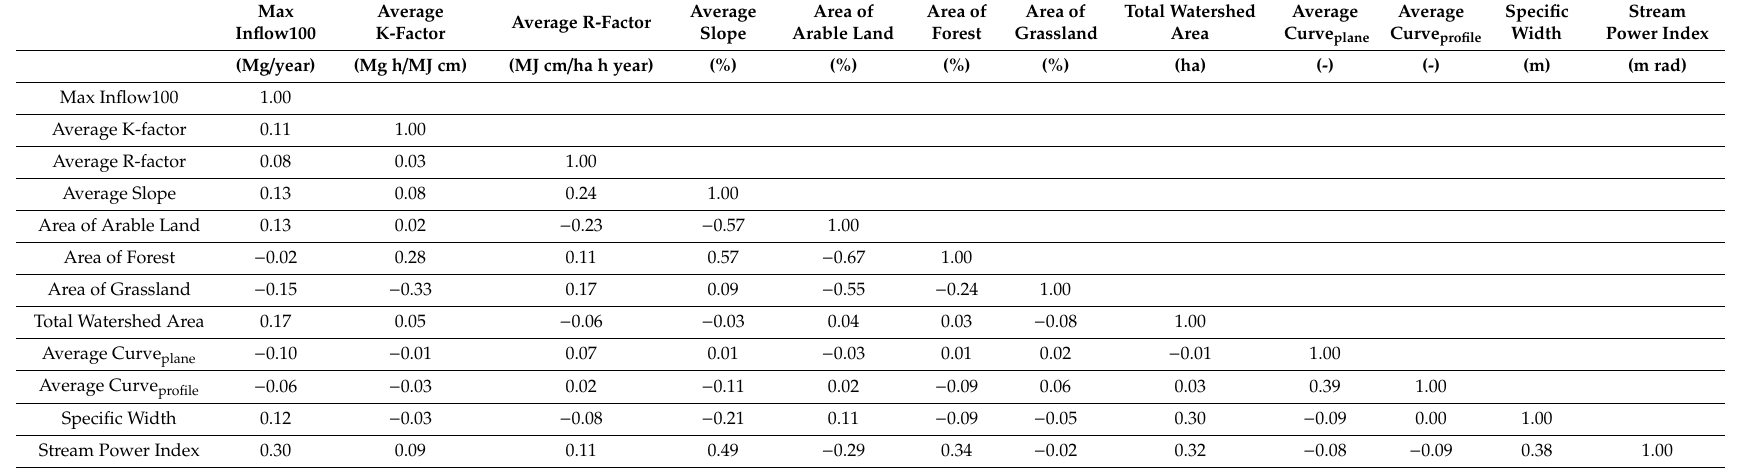
Table 4. Correlation matrix between Inflow100 and studied